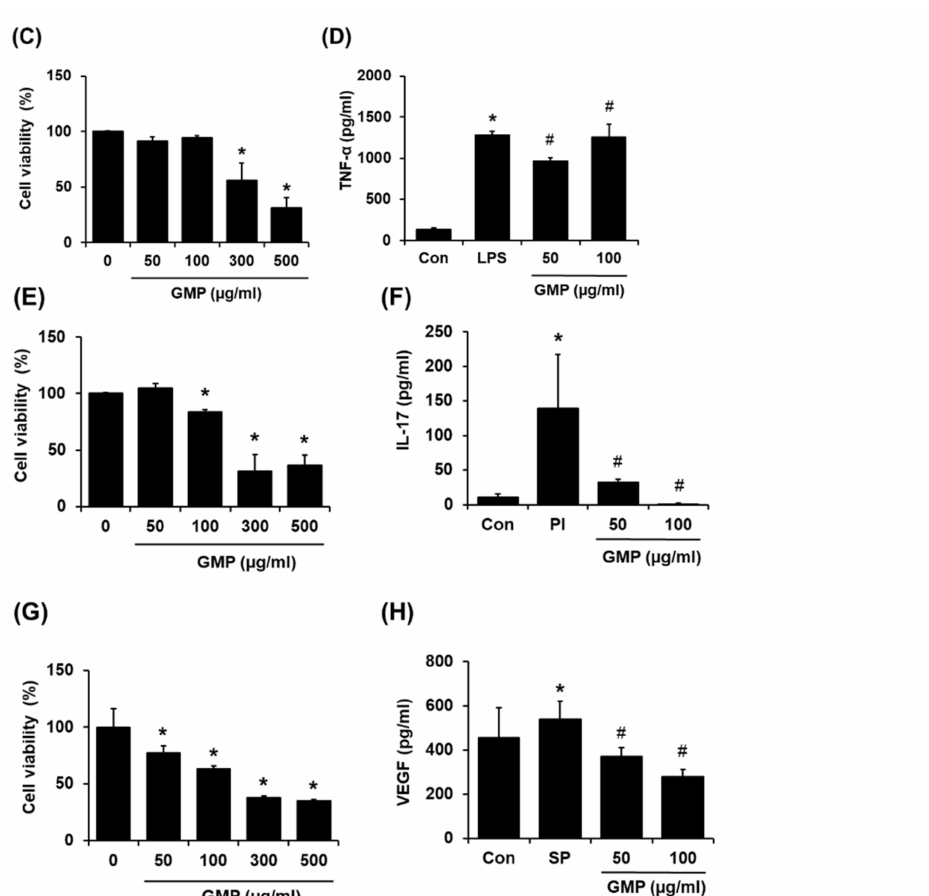
Figure 6. Effect of GMP on the inflammatory responses in vitro . ( A ) Effect of GMP on cell viability of HaCaT cells. ( B ) Effect of GMP on TARC and MDC production in TI-stimulated HaCaT cells. ( C ) Effect of GMP on cell viability of Raw264.7 cells. ( D ) Effect of GMP on TNF- α level in LPS- stimulated Raw264.7 cells. ( E ) Effect of GMP on cell viability of EL4 cells. ( F ) Effect of GMP on IL-17 level in PI-stimulated EL4 cells. ( G ) Effect of GMP on cell viability of HMC-1 cells. ( H ) Effect of GMP on VEGF production in SP-stimulated HMC-1 cells. Data represent the means ± SDs. * p < 0.05 vs. the Con, # p < 0.05 vs. the TI-treated cells, # p < 0.05 vs. the LPS-treated cells, # p < 0.05 vs. the PI-treated cells. # p < 0.05 vs. the SP-treated